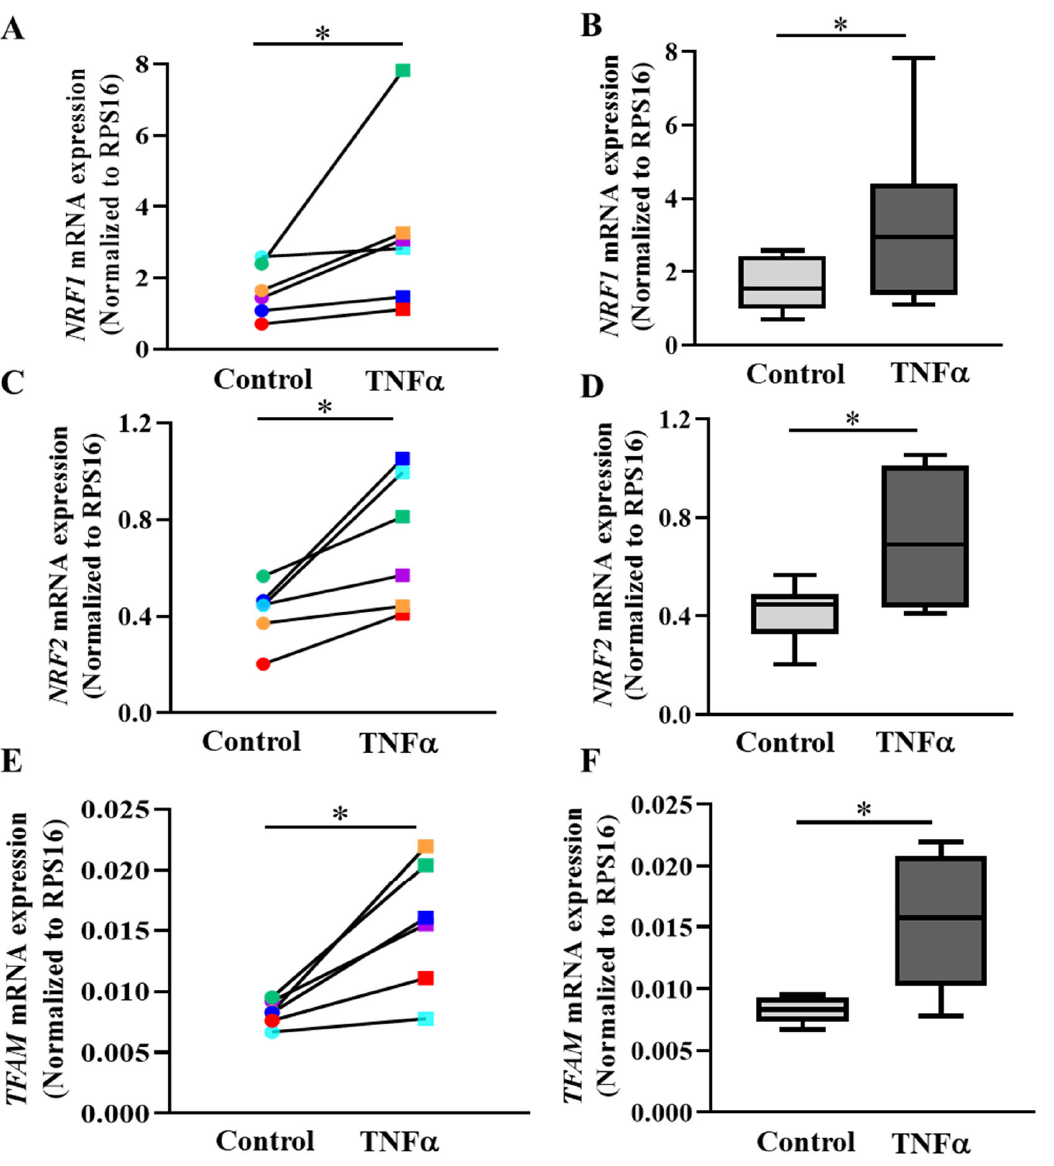
Figure 8. TNF α increases mRNA expression of NRFs and TFAM genes in hASM cells. The mRNA expressions of NRF1 ( A , B ) , NRF2 ( C , D ), and TFAM ( E , F ) were quantified using specific primer sets via qPCR and represented as a fold change relative to RPS16. ( A , C , E ). The mRNA expression levels of all three genes were compared between TNF α -treated (20 ng/mL for 6 h) (squares) and untreated (circles) hASM cells for each of six patient hASM samples (represented by different colors) (* p < 0.05; n = 6). ( B , D , F ). The mRNA expression of NRF1 , NRF2 and TFAM genes were summarized as box ‐ whisker plots showing the median and minimum to maximum distribution across the six patient samples. Statistical analyses on measures of mtDNA copy number were performed on n = 6 patient hASM samples using a paired t ‐ test (* p < 0.05).